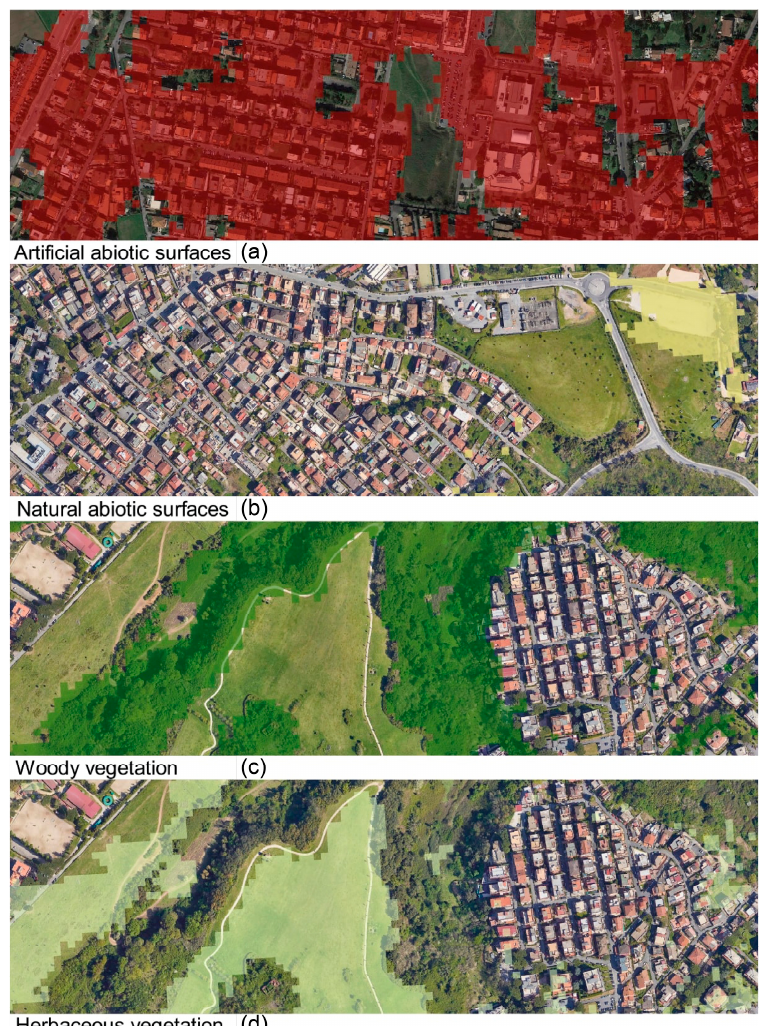
Figure 8. Examples of land cover classes with reference to the single-date classification through the VGG16 algorithm. The first image from above ( a ) represents an artificial abiotic surface, the second ( b ) a clay area classified as a natural abiotic surface, while the last two images are examples of natural areas covered by woody vegetation ( c ) and herbaceous vegetation ( d ).